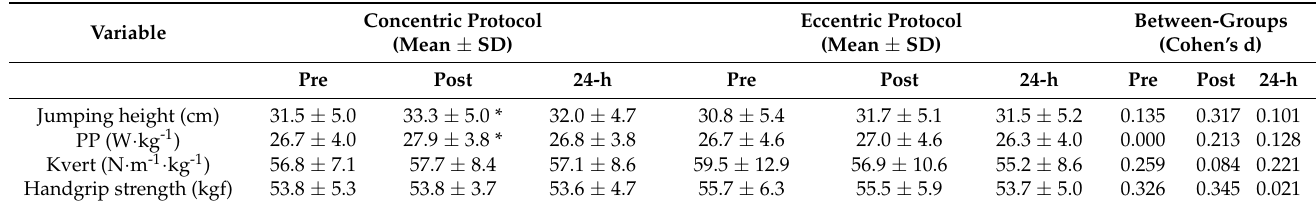
Table 2. Their reliability values were excellent (ICC > 0.9; CV < 10%) in all cases, except for Kvert with an ICC = 0.56 and a CV = 18.8%. The jumping height statistically increased immediately after concentric (6.1 ± 6.1%, p = 0.028, d = 0.364) but not eccentric cycling (+3.2 following the concentric ( p = 0.898, d = 0.103) and eccentric protocols ( p = 0.428, d = 0.131). Table 2. Functional performance changes induced by the cycling protocols. Table 2. Functional performance changes induced by the cycling